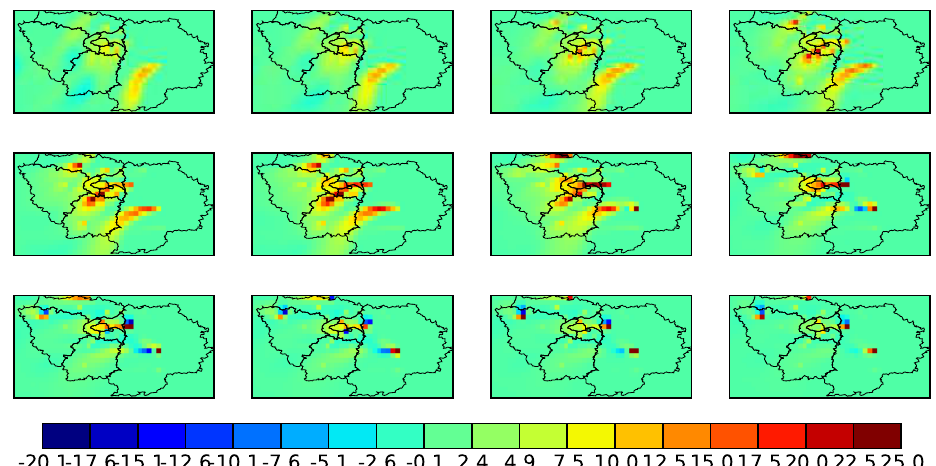
Fig. 8. Evolution of the difference between reference and plume-in-grid SO 2 ground concentrations during twelve hours, from 23 August at 03:00 (local hour) to 23 August at 14:00. Unit is µgm − 3 . Plume-in-grid concentrations are subtracted to the reference concentrations.